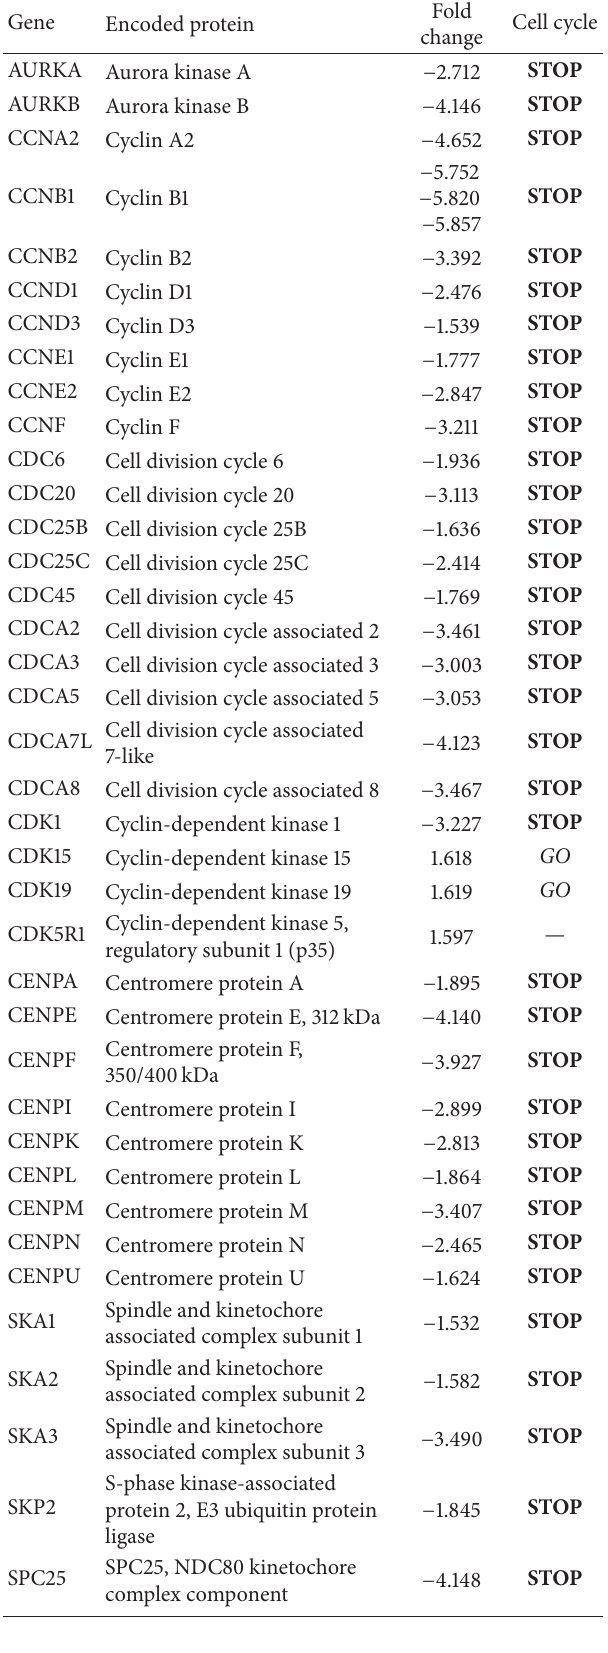
Table 1: Selected genes related to cell